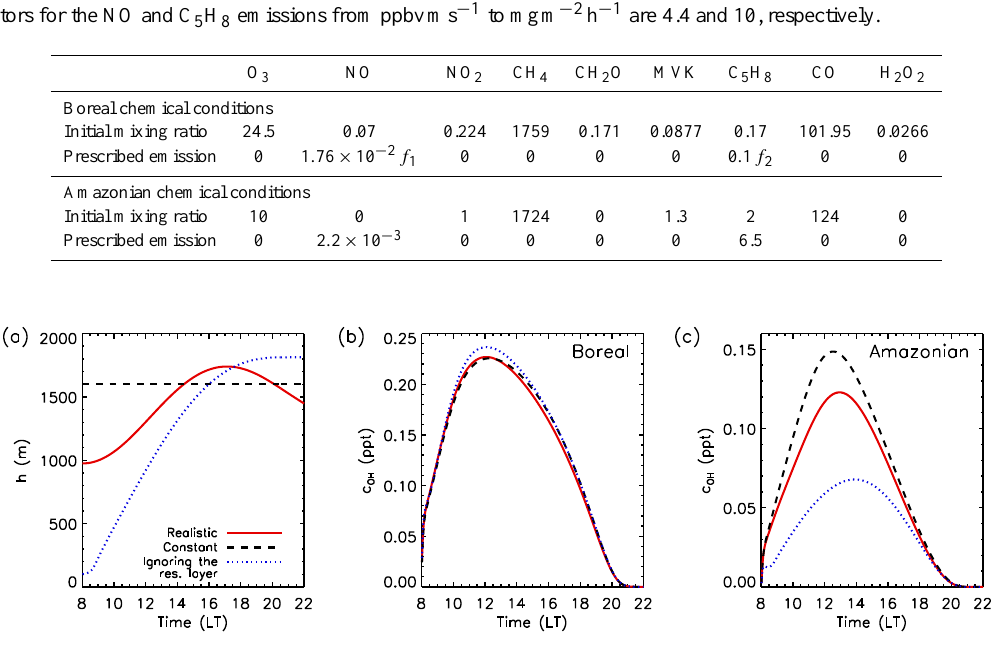
Table 4. Overview of the prescribed initial mixing ratios (ppbv) and the emissions at the surface (mg m − 2 h − 1 ) of the reactive species for Sect. 3.3 for both boreal and Amazonian chemical conditions. Not listed are the values for species without emissions and zero initial mixing ratio and the values for O 2 and N 2 . These latter two species have constant mixing ratios of 2 × 10 8 and 8 × 10 8 ppbv, respectively. For the emissions, the functions f 1 =